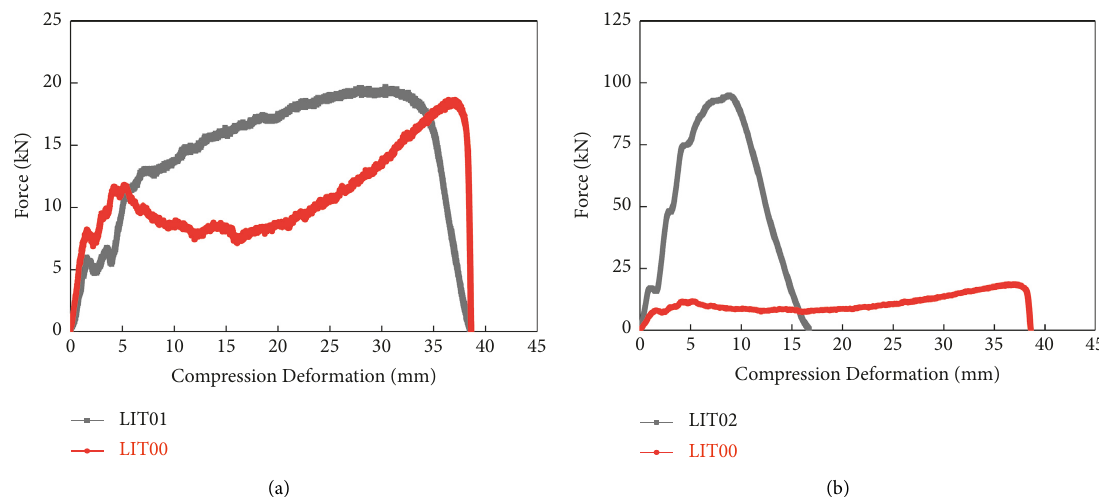
Figure 8: Diagram of impact force and compression deformation of specimen. (a) Groups F and H. (b) Groups G and H.